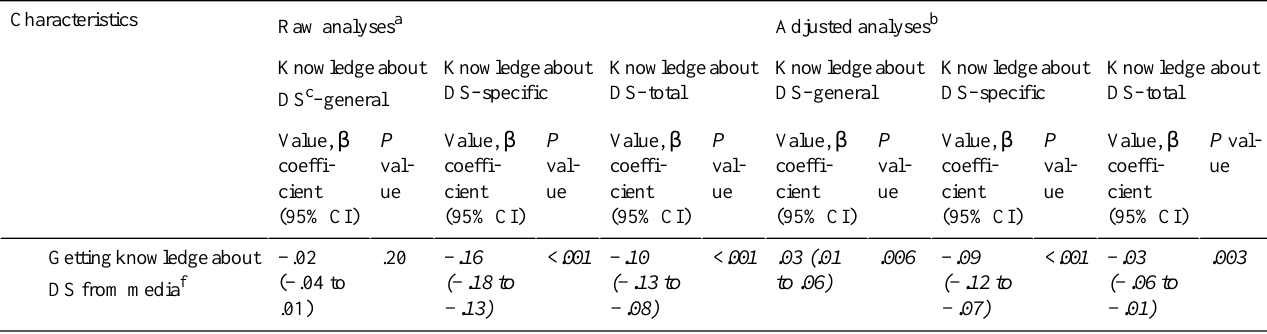
Table 4. Characteristics of a model to describe knowledge about dietary supplements. The total sample of 6273 internet users was included. Test statistics, P value and coefficient of determination of a full model are F (5,6267)=568.2; P <.001; R 2 =0.312, respectively.